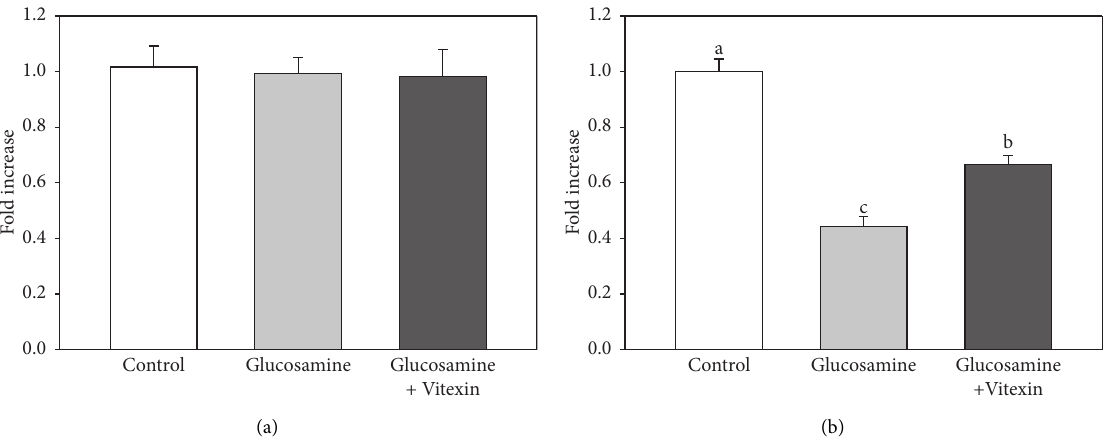
Figure 4: Influence of vitexin on cell viability and glucose uptake in HepG2 cells. (a) Cell viability; (b) triglyceride content. Numbers represent mean ± SE ( n � 3). Means with different letters were significantly different at P < 0 .